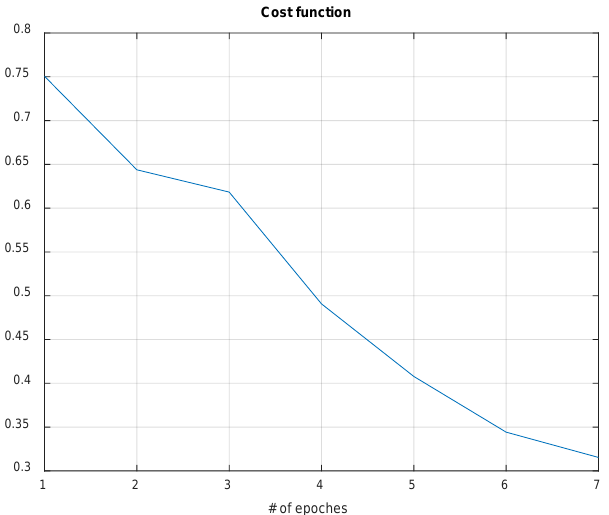
Figure 11. Data graph of the CNN cost function evolution vs. number of epochs in C3D3a_4C. The MATLAB code for a sample mean of C3D3a_4C data and its confidence interval, when the sample size n = 10 is, as follows (Box 3).